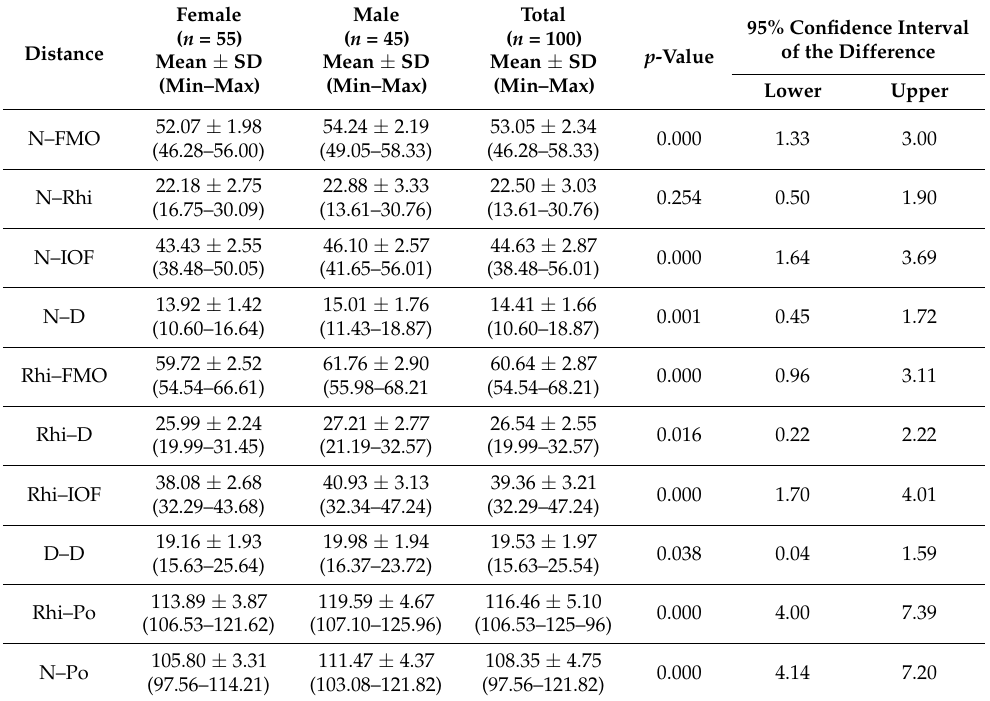
Figure 5. Distance values distribution according to gender. Table 1. Distance values (in mm) between the anthropometric points.